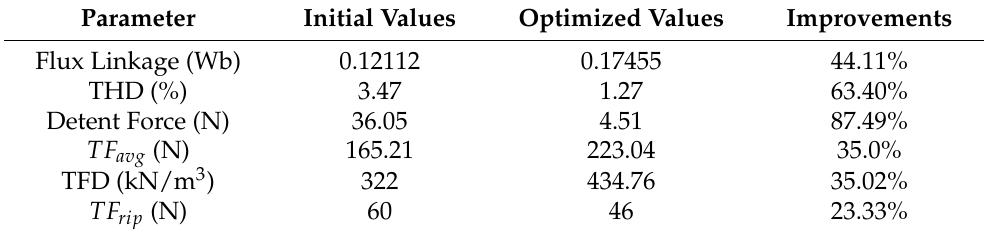
Table 4. Performance based comparison of initial design and optimized